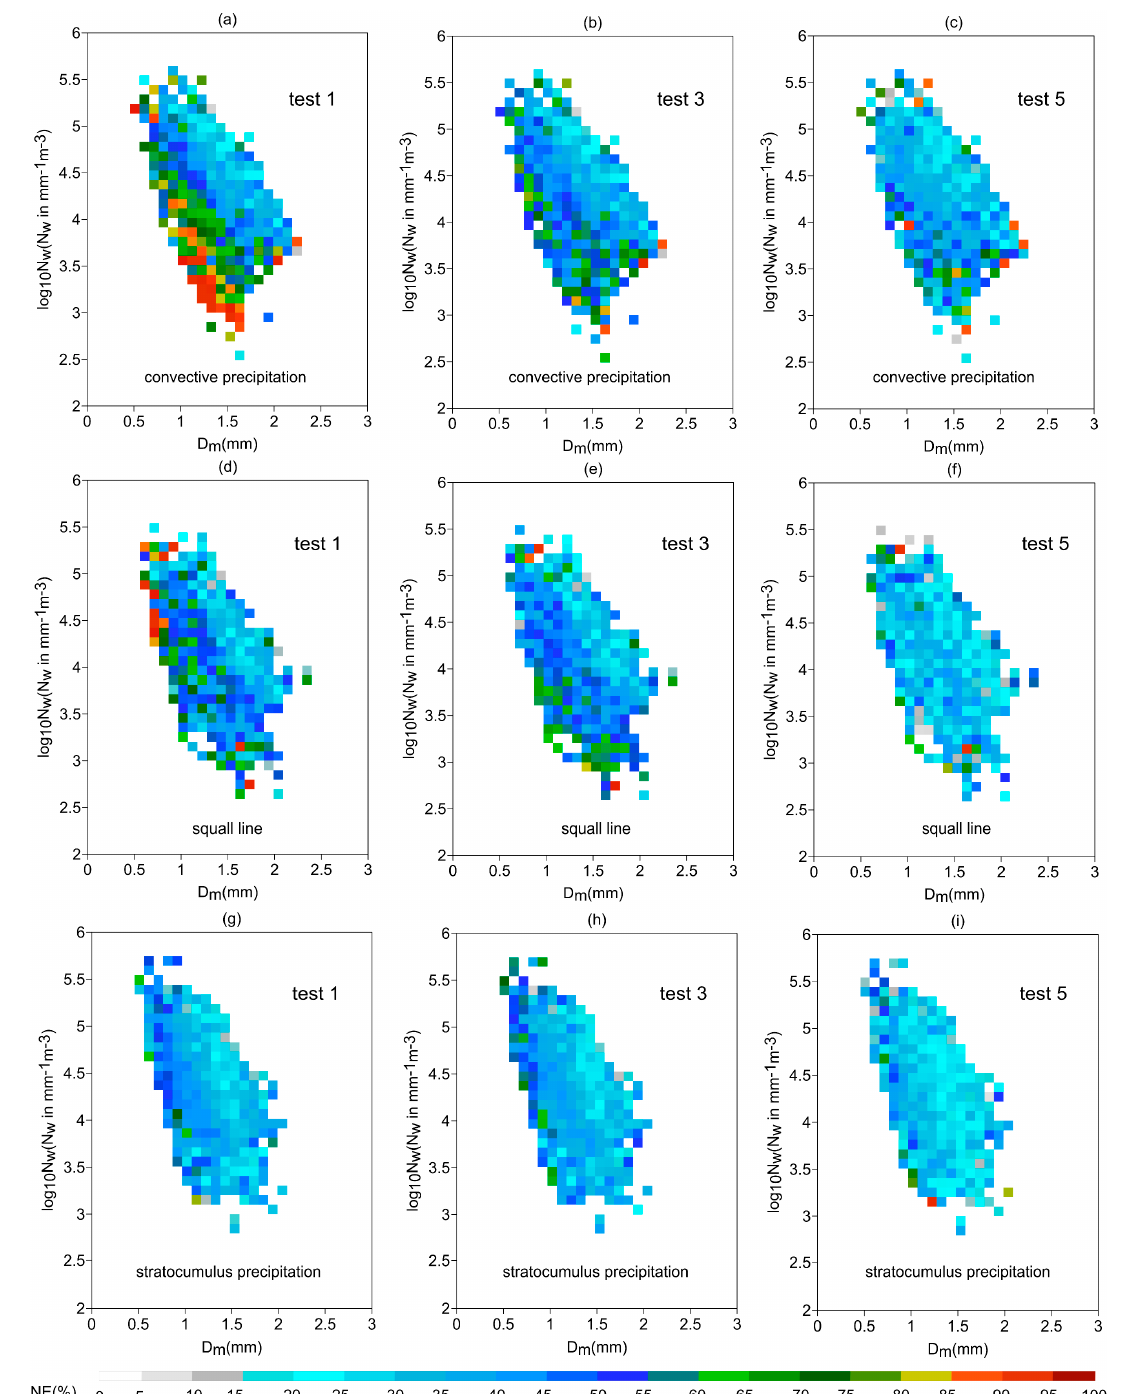
Figure 9. ( a – i ) NEs of log 10 N w versus D m . The top, middle, and bottom rows show the results for convective precipitation, squall line, and stratocumulus precipitation, respectively. The left, middle, and right columns show the results from tests 1, 3, and 5, respectively. D m and N w were derived from good-quality Z H and Z DR for the corresponding events.